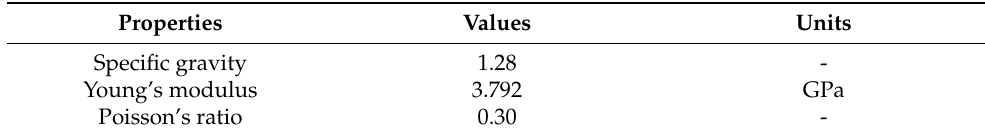
Table 3. Material properties of epoxy.